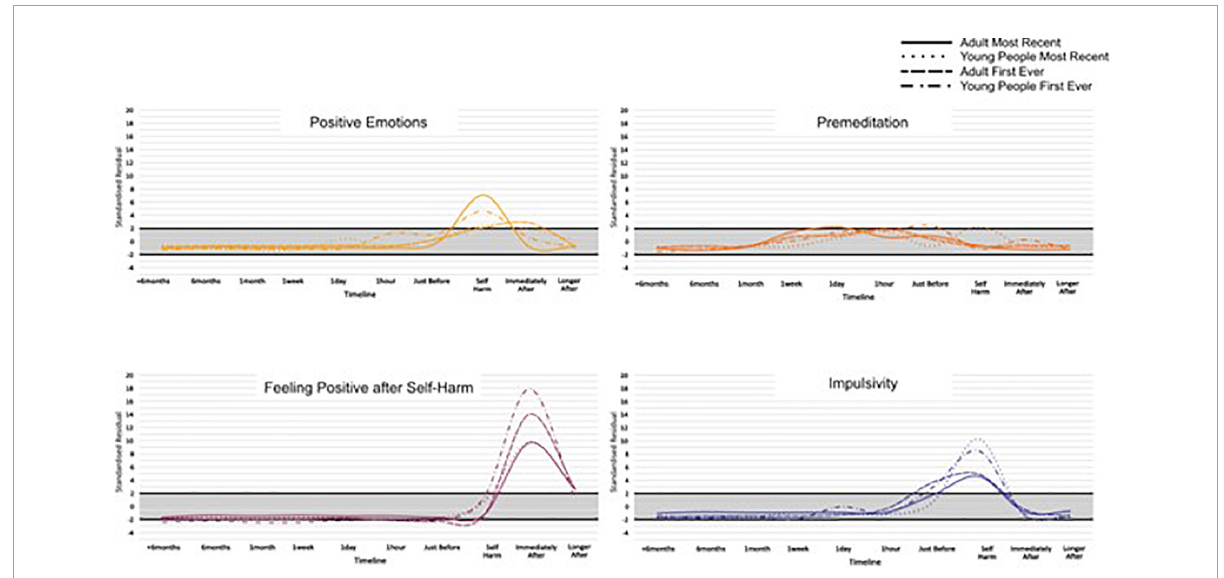
FIGURE6 Indicator Wave graphs comparing standardised residuals (SRs) for each group across the timeline, for the categories: Positive emotions, premeditation, feeling positive after self-harm, and impulsivity.